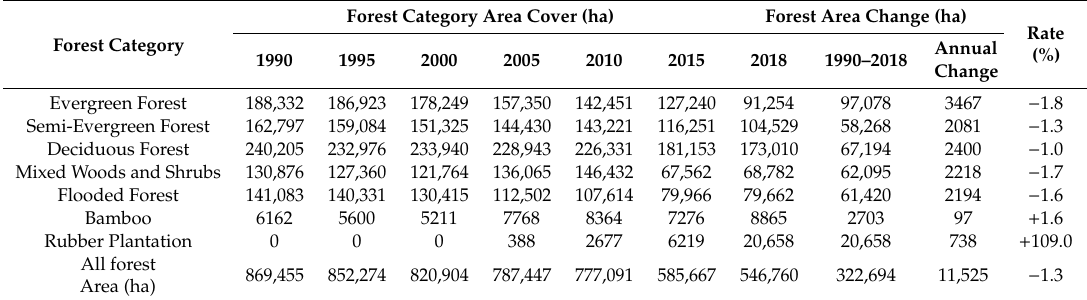
Bamboo Rubber Plantation All forest Area